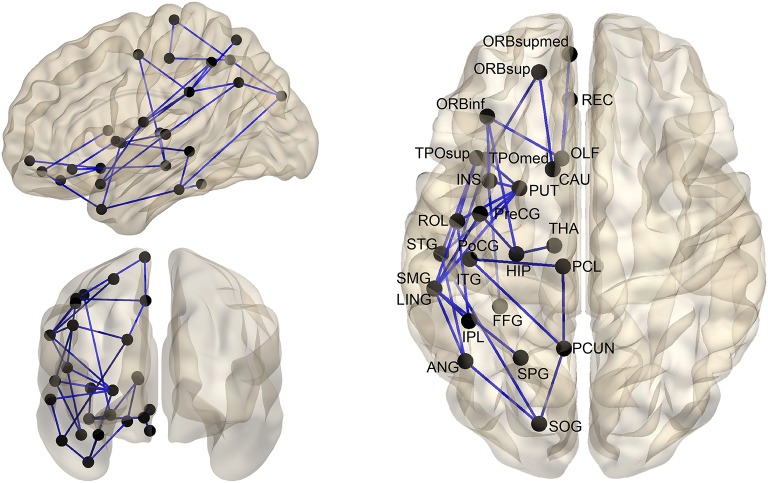
The distribution of structural connections showing significant (p < 0.05, NBS-corrected) hemisphere effect. These connections formed a single connected network with 26 nodes and 33 connections. For the abbreviations of the cortical regions, see Table 2.